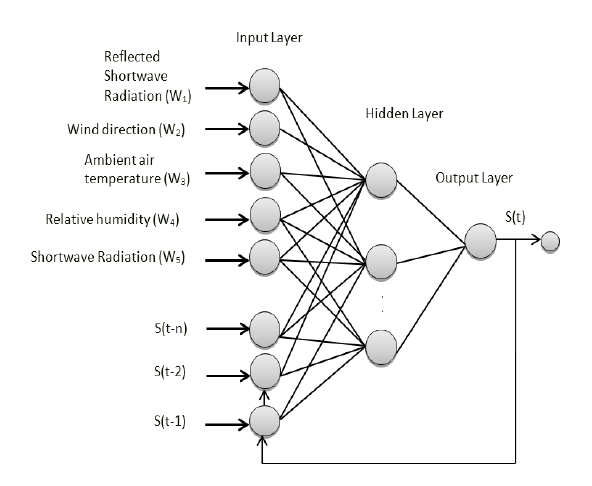
Figure 1. NARX model